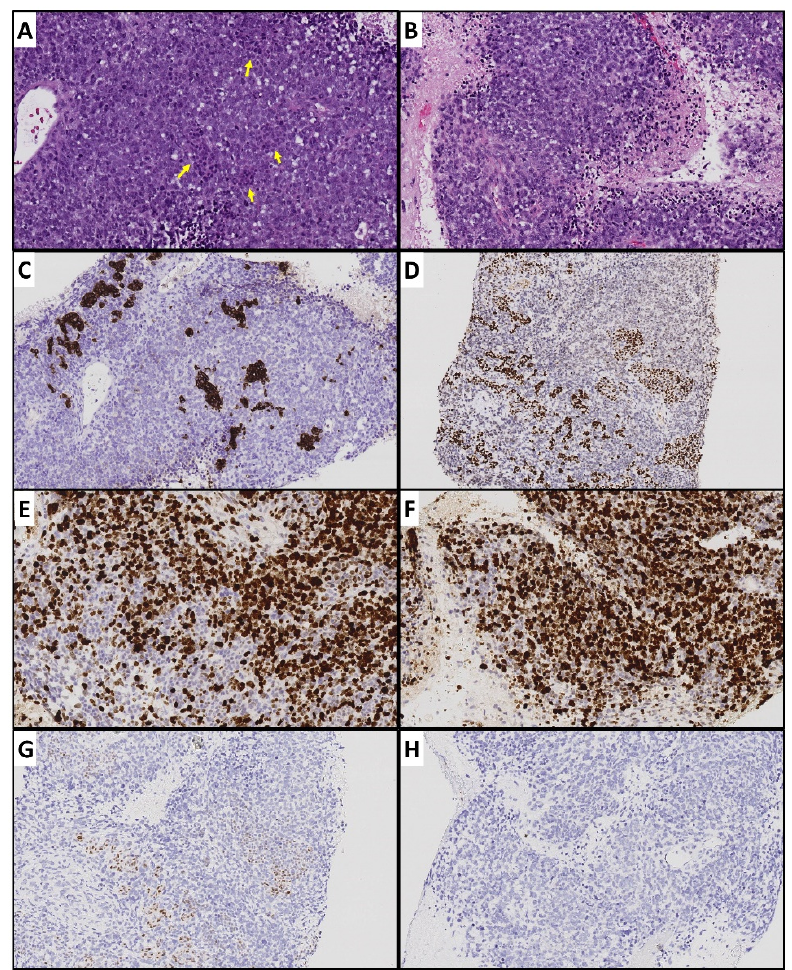
Figure 3. Metastatic de-differentiated carcinoma in a patient with well-differentiated pancreatic neuroendocrine tumor. ( A ) Representative tumor section containing foci of well-differentiated com- ponent (yellow arrows). ( B ) Poorly differentiated carcinoma with extensive necrosis and abundant apoptosis and mitoses. ( C ) Well-differentiated foci with synaptophysin expression but no expression in poorly differentiated component. ( D ) Well-differentiated foci with strong INSM-1 (another neu- roendocrine marker) expression. ( E , F ) Relatively low Ki67 index in well-differentiated component and high Ki67 poorly differentiated component. ( G ) Normal p53 expression in well-differentiated component. ( H ) Complete loss of